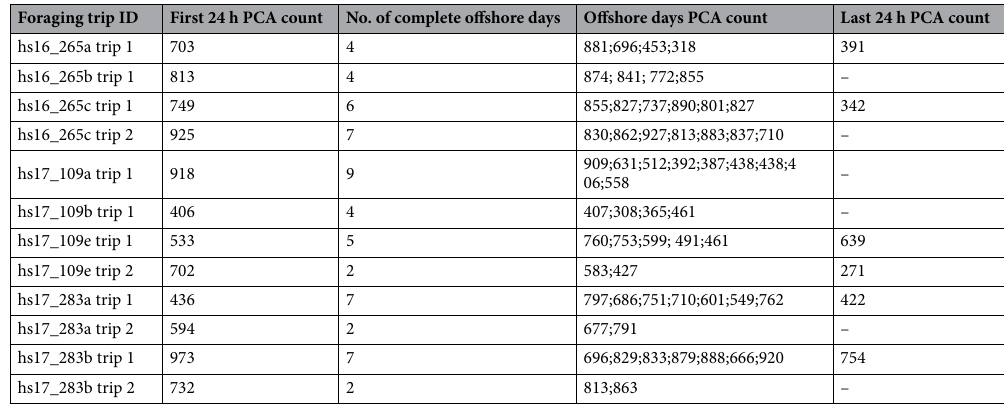
Table 2. Number of presumed prey captures (PCA) during each 24-h period of the foraging trip. The first and last 24 h encompass travel to and from an offshore site. For trips in which the tag recording ended early, the final 24 h is included in the offshore